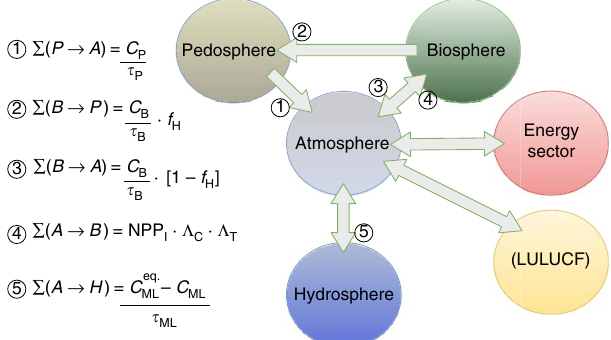
Figure 7 | Schematic illustration of gross flows through the global carbon cycle. At left: FeliX model formulas for calculating gross carbon flux from reservoir X to reservoir Y, S (X - Y) (PgC per year). FeliX model parameters are based on the C-ROADS model 34 and are defined and discussed in further detail in the model’s technical documentation